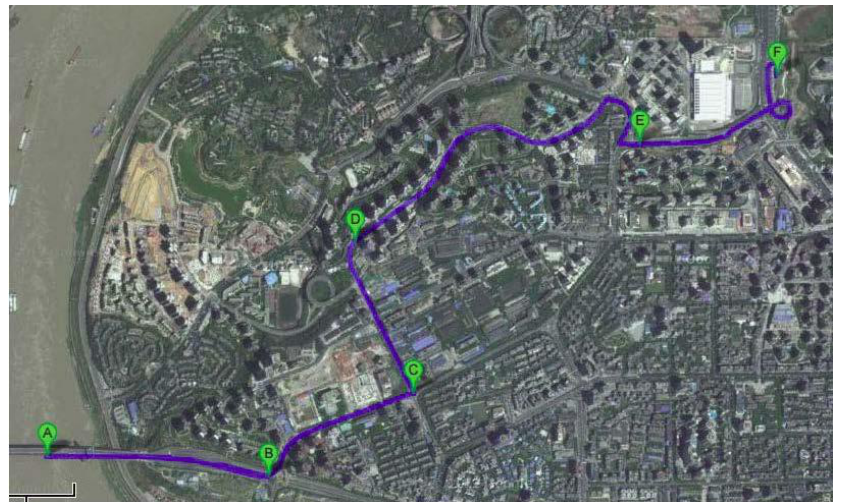
Figure 6. Testing trajectory.